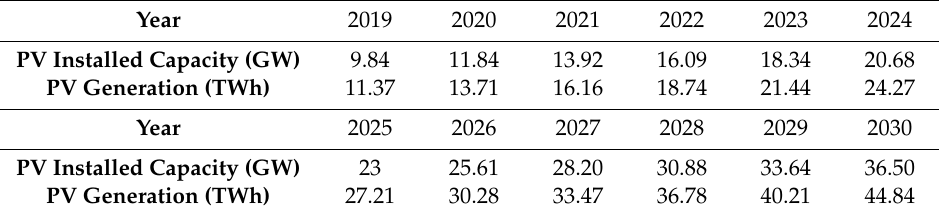
Table 8. The predicted PV installed capacity and PV generation from 2019 to 2030.